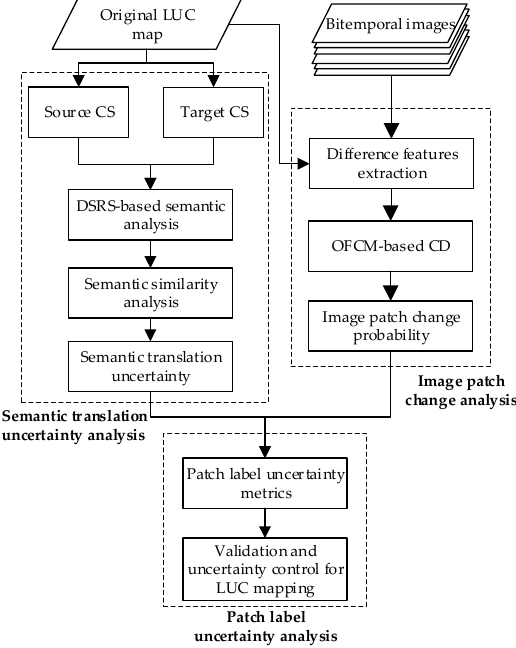
Figure 3. General framework of the proposed uncertainty assessment schema.